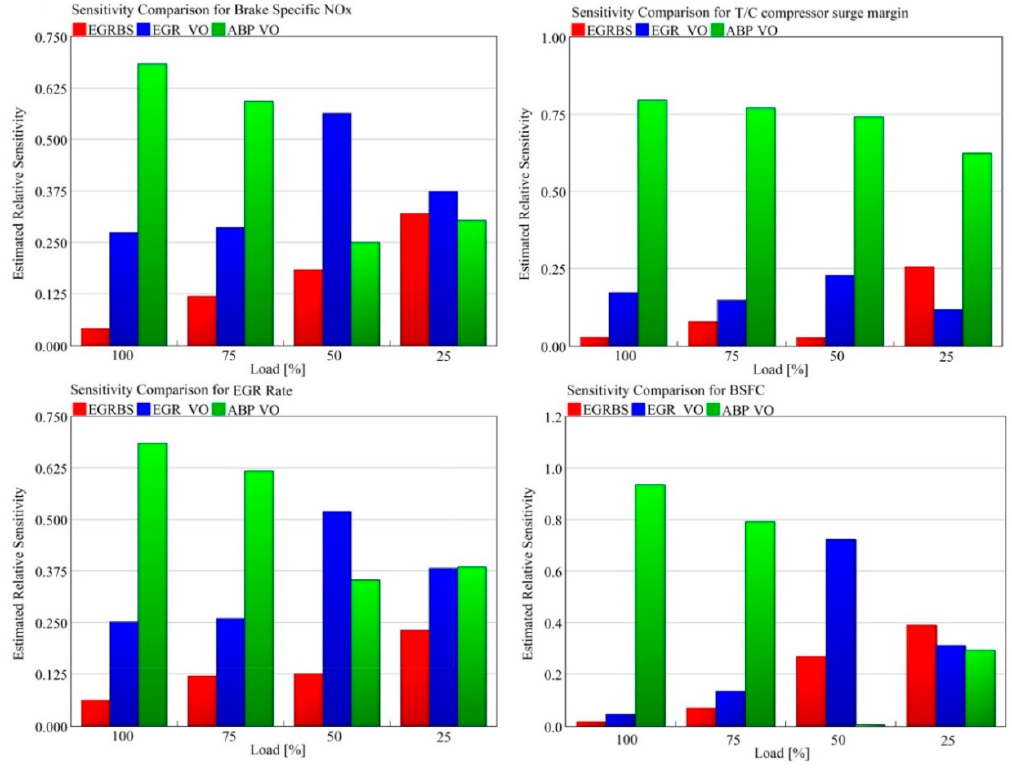
Figure 5. Sensitivity analysis results.